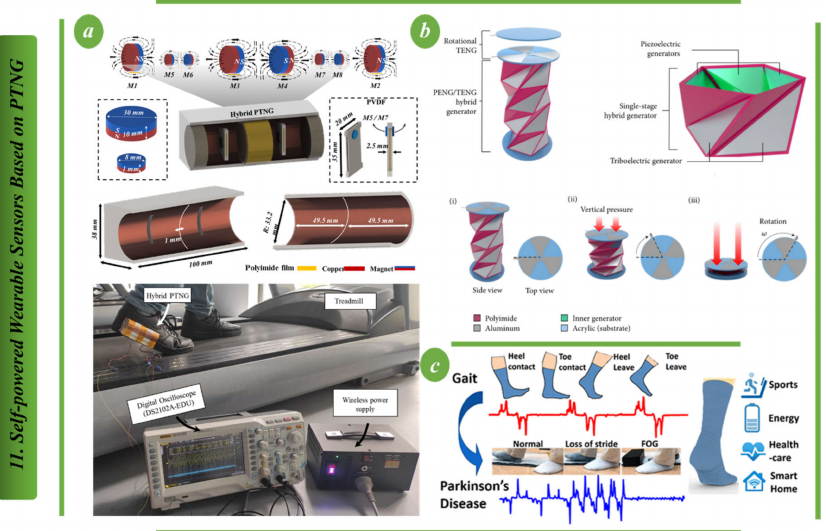
Figure 11. Self-powered wearable sensors based on PTNG: ( a ) Structure of the design for the hybrid PTNG that is used for walking sensing [104]. ( b ) TC piezoelectric/triboelectric hybrid generator diagram (TCO-HG) [105]. ( c ) Creating a self-powered cotton sock with piezoelectric and triboelectric nanogenerators